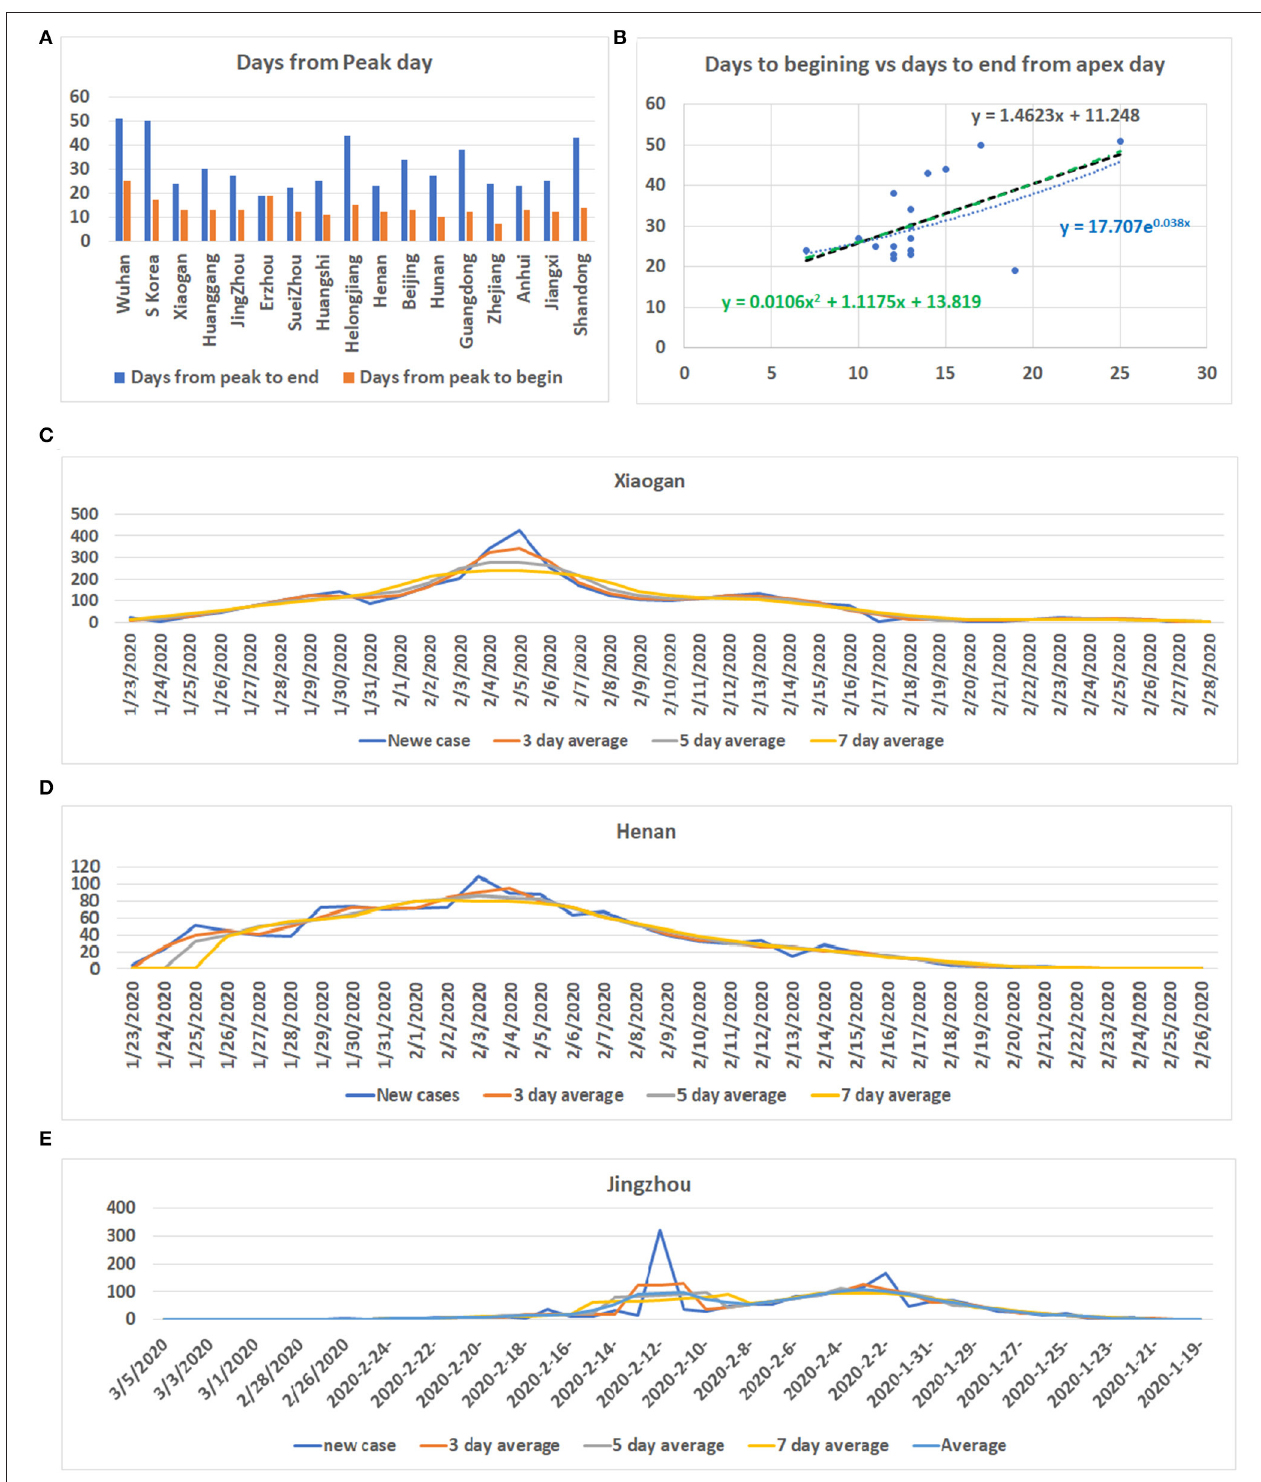
FIGURE 1 | Information for COVID-19 pandemic. (A) The number of days from the beginning of the COVID-19 onset to the apex of onset and the number of days from the apex of onset to no new cases in each region. Vertical axis: days, Horizontal axis: cases. (B) Correlation between the date before the apex of onset and the date after the apex. Vertical axis: days after apex day, Horizontal axis: cases before and including apex day. (C) The distribution of the number of cases in Xiaogan City during all periods measured. It shows that there is a very obvious apex. (D) The daily distribution of patients in Henan Province during the pandemic. The apex onset date is not obvious. (E) The distribution of patients in Jingzhou shows that there are two apexes of incidence.